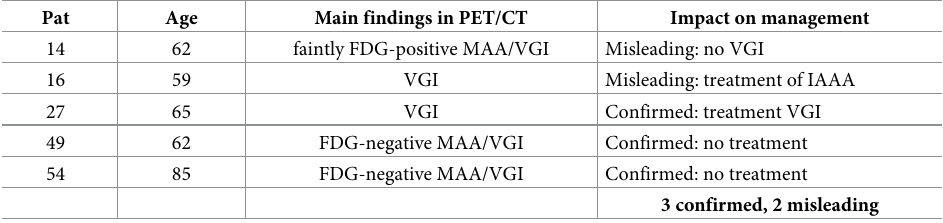
Table 7. Impact on patient management of follow-up PET/CT scans with the referral question: VGI (n =